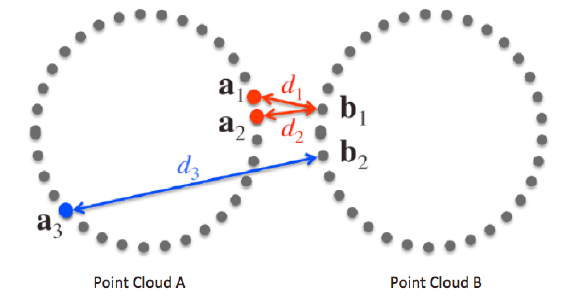
Figure 3. Inter-point distance between point a i in point cloud A and its nearest neighbour point b j in point cloud B.